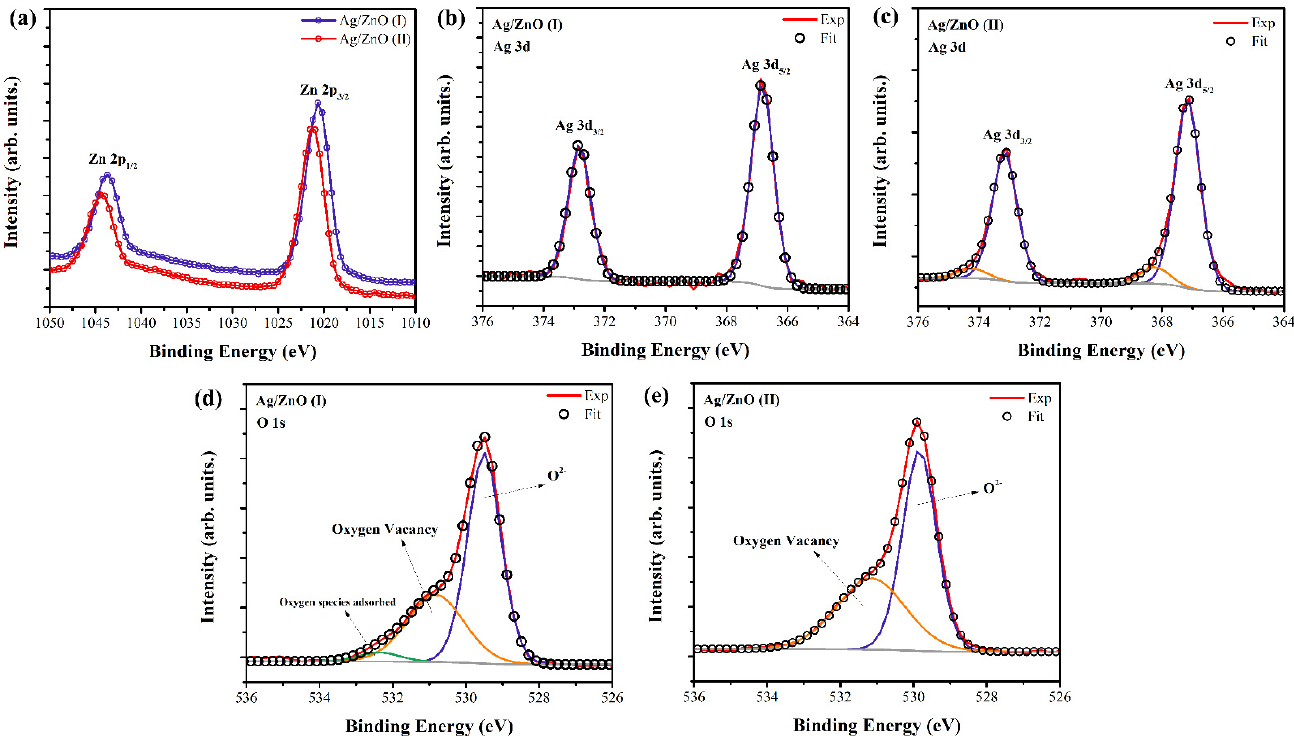
Figure 6. XPS spectra of Ag/ZnO particles obtained by two different synthesis routes. High- resolution regional XPS spectra of ( a ) Zn (2p), ( b,c ) Ag (3d), and ( d,e ) O (1s).